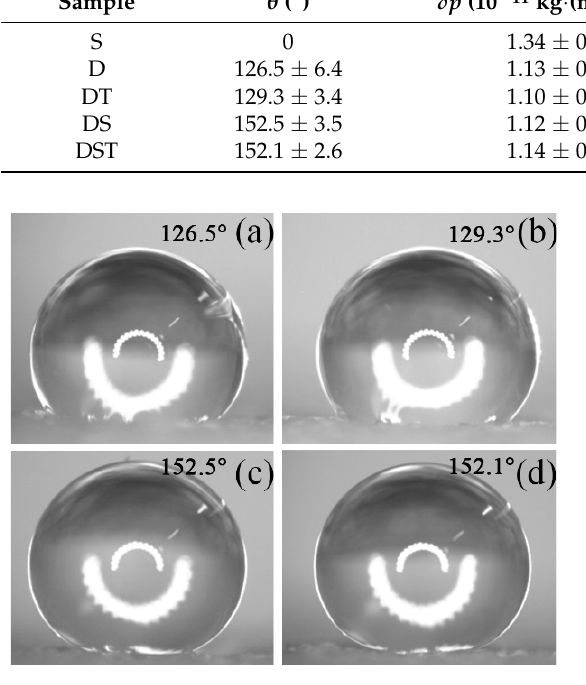
Figure 2. Static contact angle images: ( a ) D; ( b ) DT; ( c ) DS; ( d ) DST.